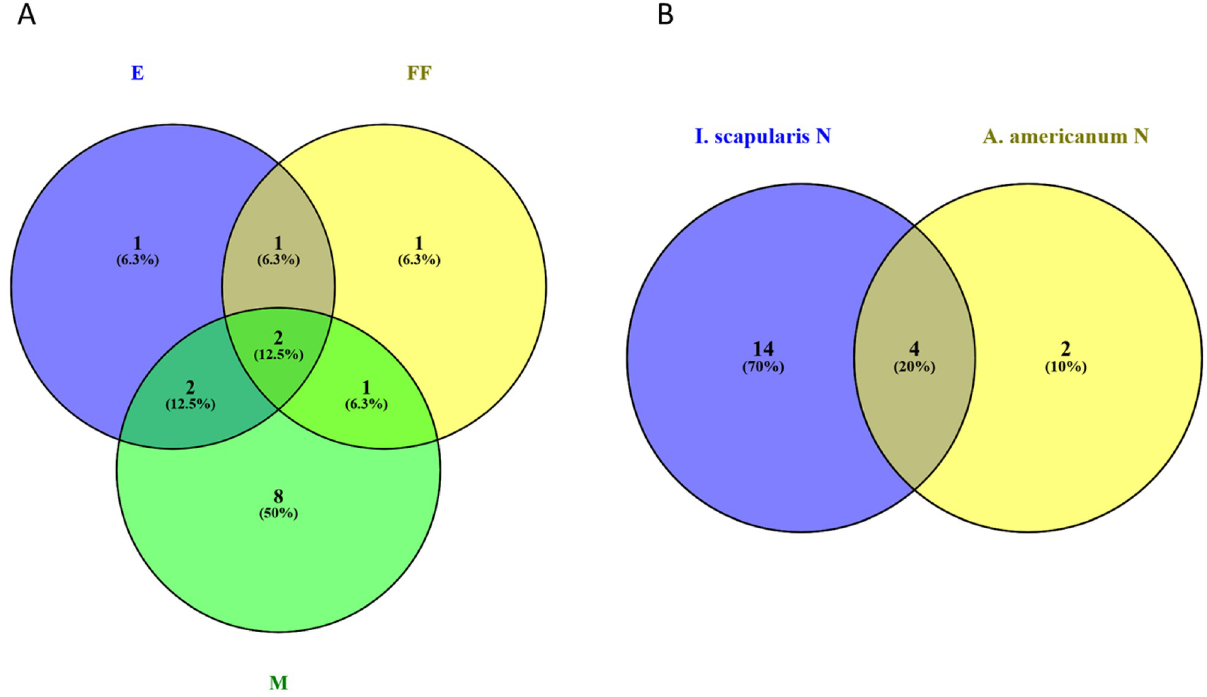
Fig 4. Core OTUs, defined as taxa present in at least 50% of samples within a group and occurring at 1% minimum relative abundance. Overlap A) among I . scapularis engorged females (FF), mated males (M), and egg masses (E) generated from deer carcasses and B) overlap between Amblyomma and Ixodes nymphs. Graphs were generated with Venny 2.1 (https://bioinfogp.cnb.csic.es/tools/venny/).